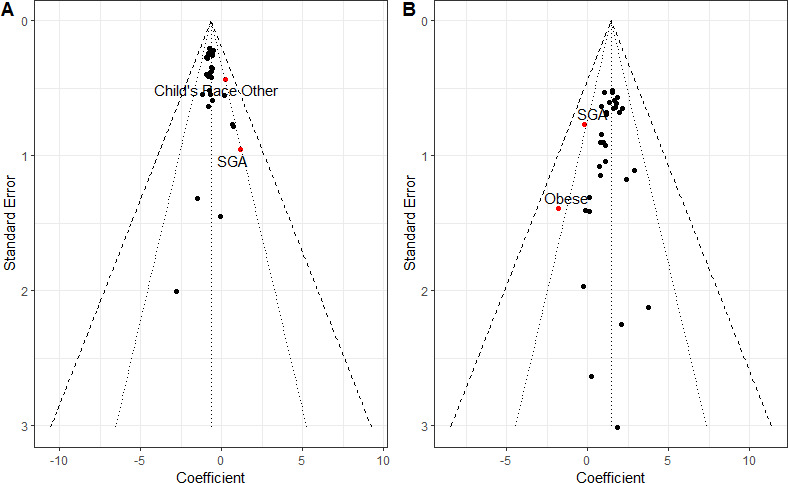
Subset analysis for all covariates used in regression models.Funnel plot demonstrating relationship effect size estimates and measurement error for subset analyses for (A) current mid-childhood asthma and (B) FEV1/FVCx100 in early-teen years. 95% CI (botted lines) and 99% CI (dashed lines) displayed.